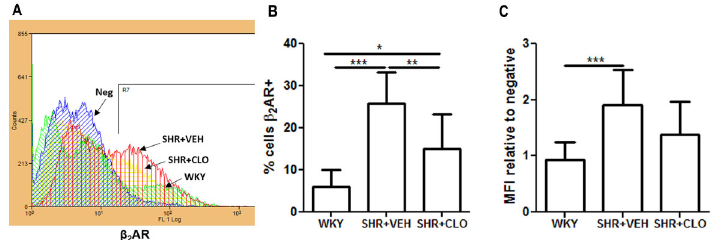
Figure 3. Representative histograms of b 2 -adrenergic receptor ( b 2 -AR) labeling ( A ). Quanti fi cation of the percent of leukocytes expressing b 2 -AR ( B ) and the median fl uorescence intensity (MFI) of the receptor ( C ) labeling in total leukocytes from WKY, SHR + VEH and SHR + CLO. Data are reported as means ± SD for n=10 animals/group. *P o 0.05, **P o 0.01, and ***P o 0.0001 (one-way ANOVA). WKY: normotensive Wistar Kyoto rats; SHR: spontaneously hypertensive rats; VEH: animals treated with vehicle; CLO: animals treated with clonidine.